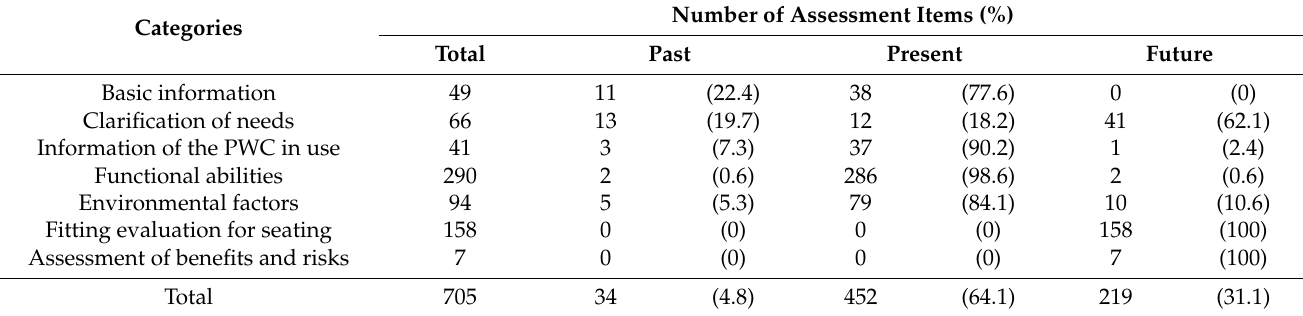
Table 2. Temporal aspects of the